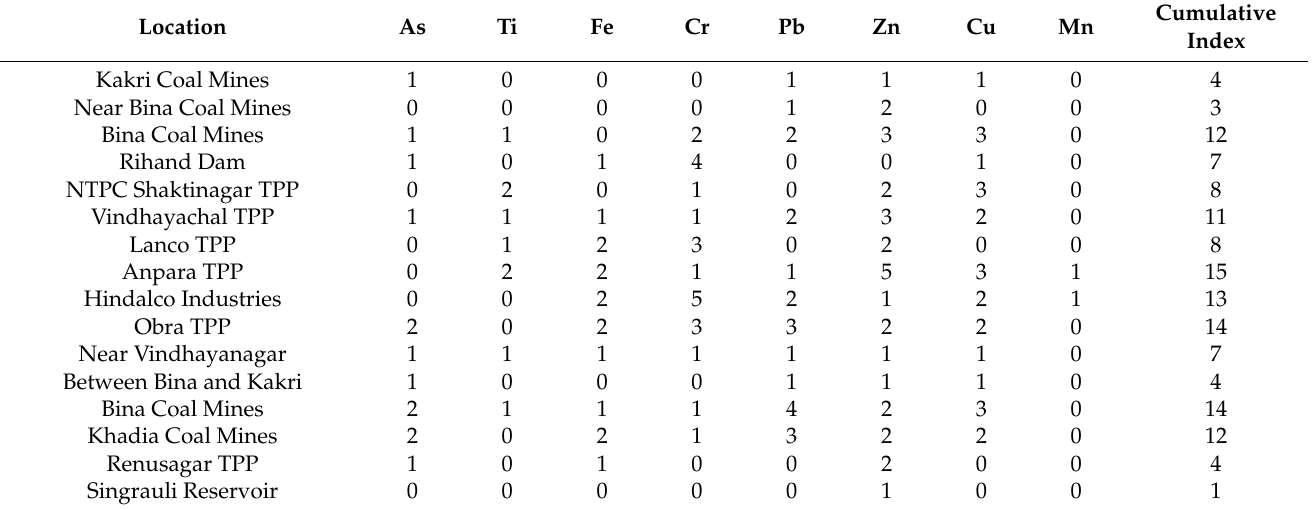
Table 7. Accumulation index calculated using Muller formula and divided into classes as described in Table 7 in Singrauli region. The background values used are As (1.5), Ti (3400), Fe (14,200), Cr (4.1), Pb (19), Cu (10), Zn (39), and Mn (390) for Rihand dam and Hindalco TPP. For all the other sites, background values taken are As (1), Ti (1500), Fe (9800), Cr (35), Pb (7), Cu (4), Zn (16), and Mn (850)